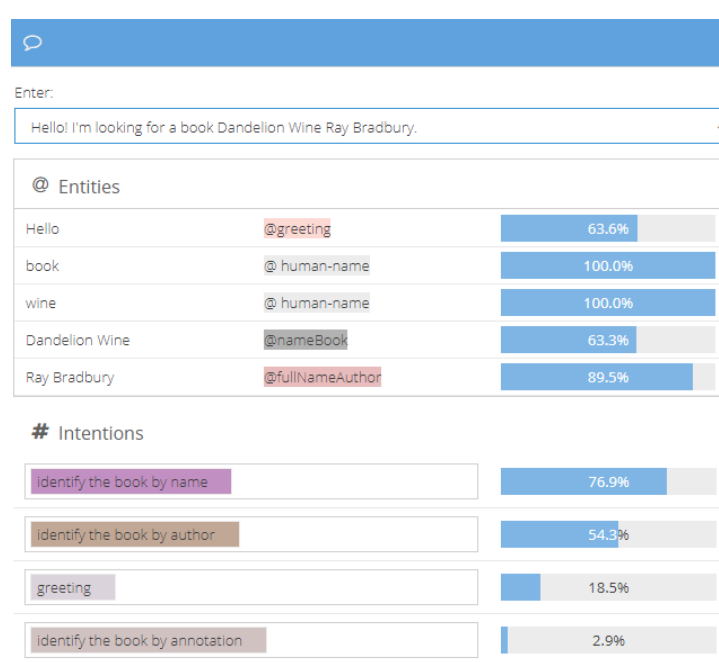
Fig. 3. An example of processing a phrase by a text analysis program agent.